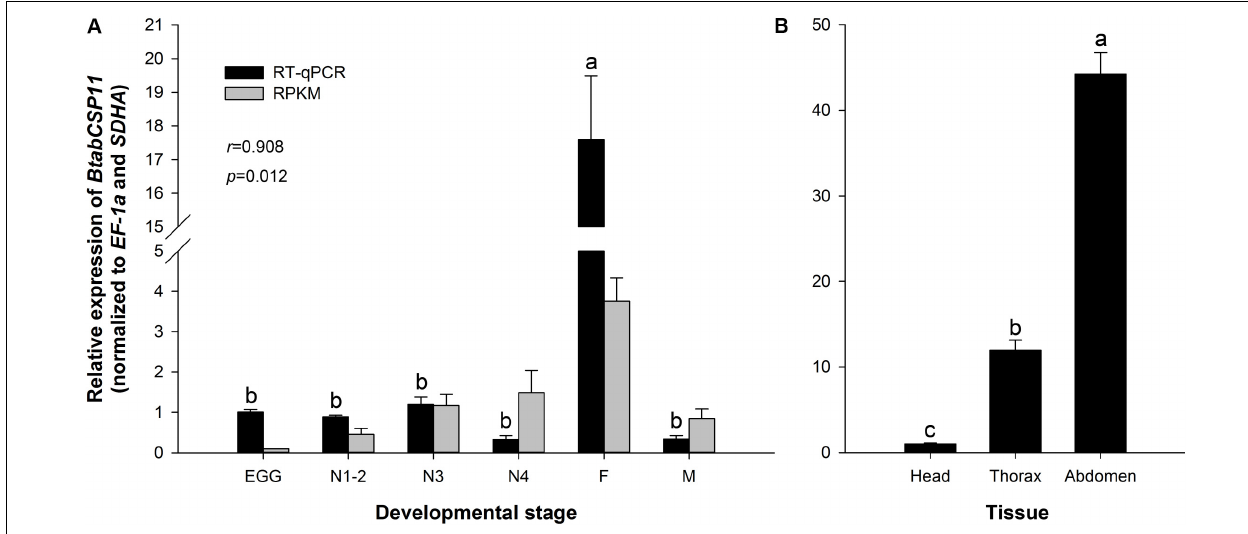
FIGURE 3 | Temporospatial expression profiles of BtabCSP11 . (A) Expression analysis of the BtabCSP11 gene by RT-qPCR (black bars) and RNA-seq (black lines). E = egg, N = nymph stages 1–4 as indicated, F = adult female, and M = adult male. (B) B. tabaci BtabCSP11 gene transcript levels in different tissue types. Standard error for each sample is represented by error bar and different letters (a, b, c) above each bar denote significant differences ( P <